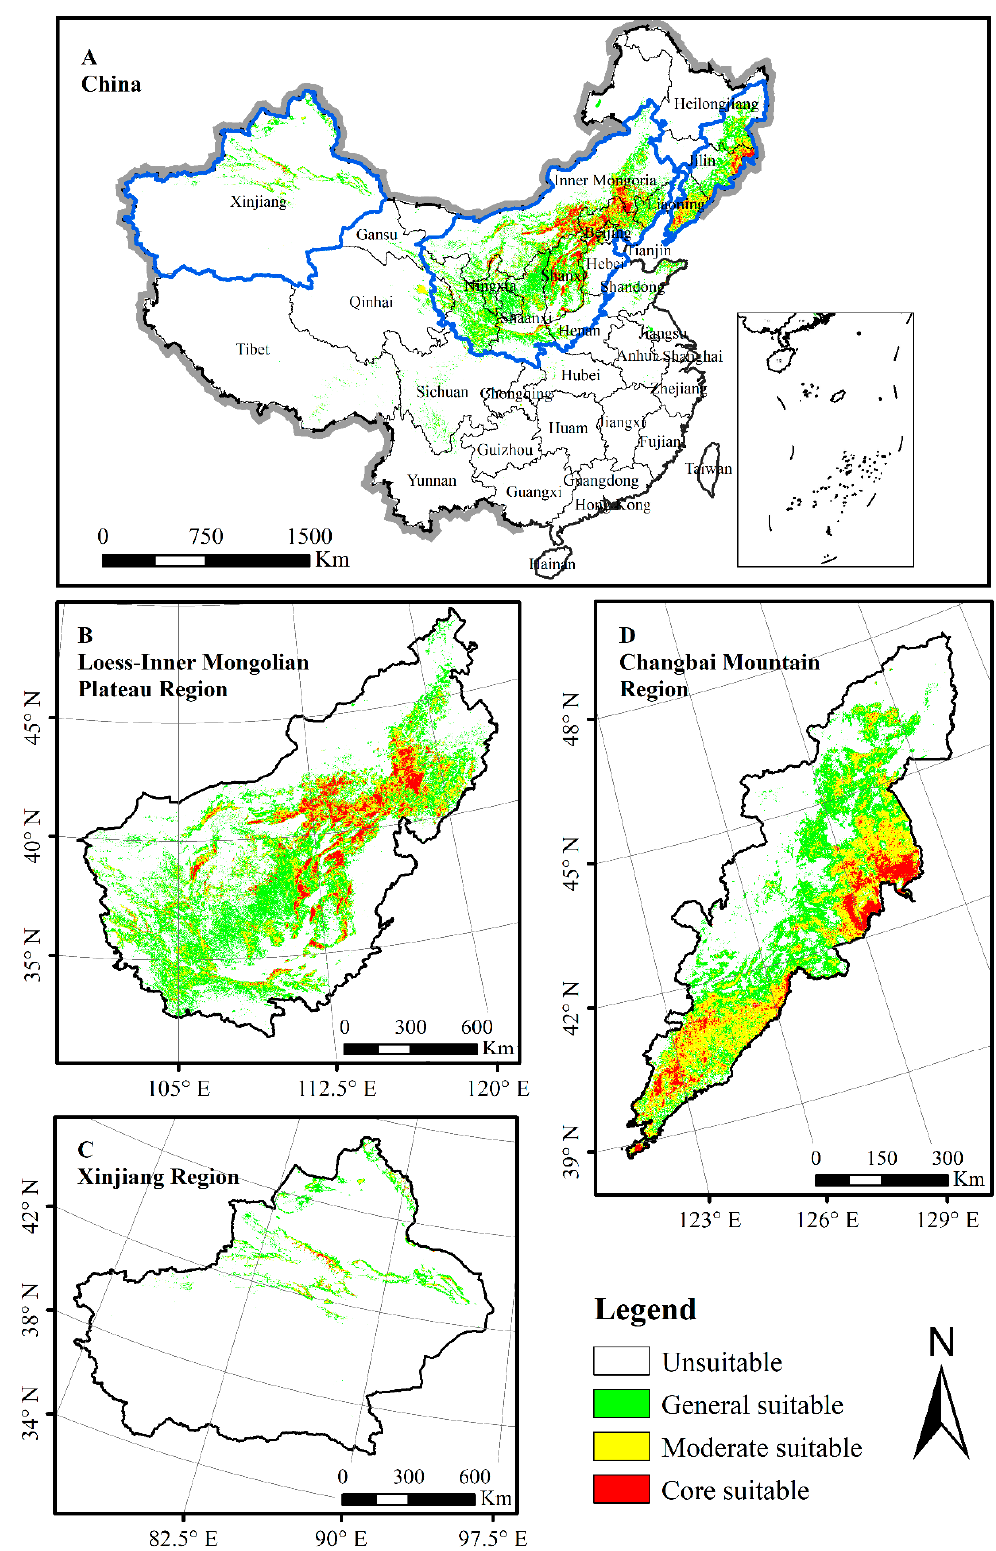
Figure 2. Potential distribution area of Juniperus rigida Sieb. et Zucc. under the current climate. The potential distribution of China was illustrated in ( A ), and ( B ), ( C ) and ( D ) shown the distribution of the Loess-Inner Mongolian plateau region, Xinjiang region and Changbai Mountain region, respectively.